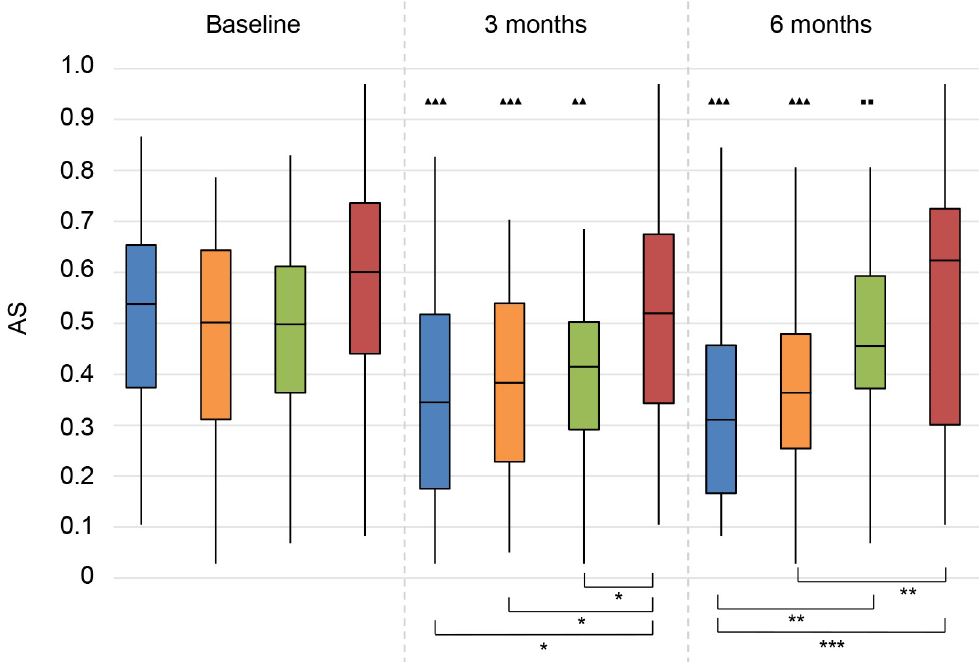
Fig 16. Abbreviated Profile for Hearing Aid Benefit questionnaire (APHAB). Aversiveness of sounds (AS). Statistical difference compared to baseline. ▲▲▲ = p < 0.001; ▲▲ = p < 0.01; ▲ = p < 0.05. Statistical difference compared to 3 months follow-up. ■■■ = p < 0.001; ■■ = p < 0.01; ■ = p < 0.05. Statistical difference between groups at same follow-up moment. ��� = p < 0.001; �� = p < 0.01; � = p < 0.05.